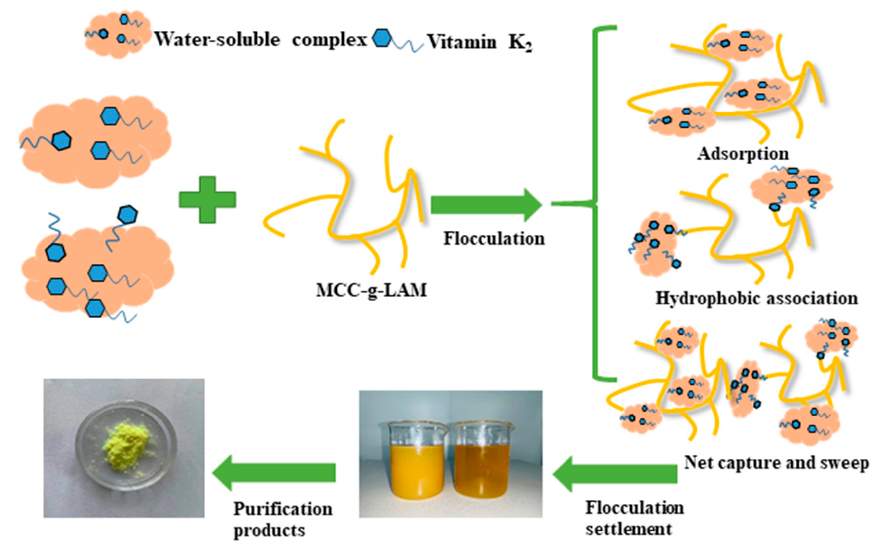
Figure 9. Schematic diagram of flocculation mechanism of MCC-g-LMA.